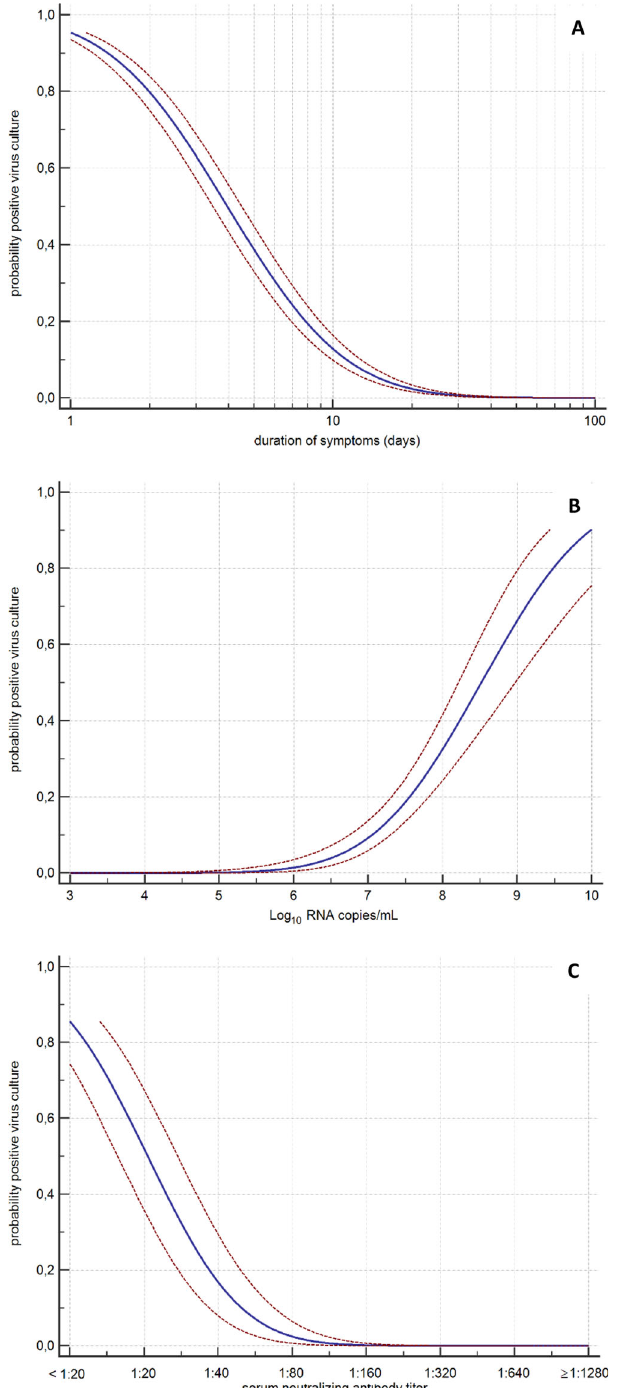
Fig. 2 Probabilities of infectious virus shedding. Probit analyses of the detection of infectious virus in respiratory samples with cell culture for duration of symptoms in days ( A ) ( n = 690 samples), viral RNA load in Log10 copies per mL ( B ) ( n = 688 samples), and serum neutralizing antibody titer ( C ) ( n = 112 samples). Blue line represent the probit curve and the dotted red lines represent the 95% con fi dence interval. Serum neutralizing antibody titers are expressed as plaque-reduction neutralization titers 50% as described previously 27 .